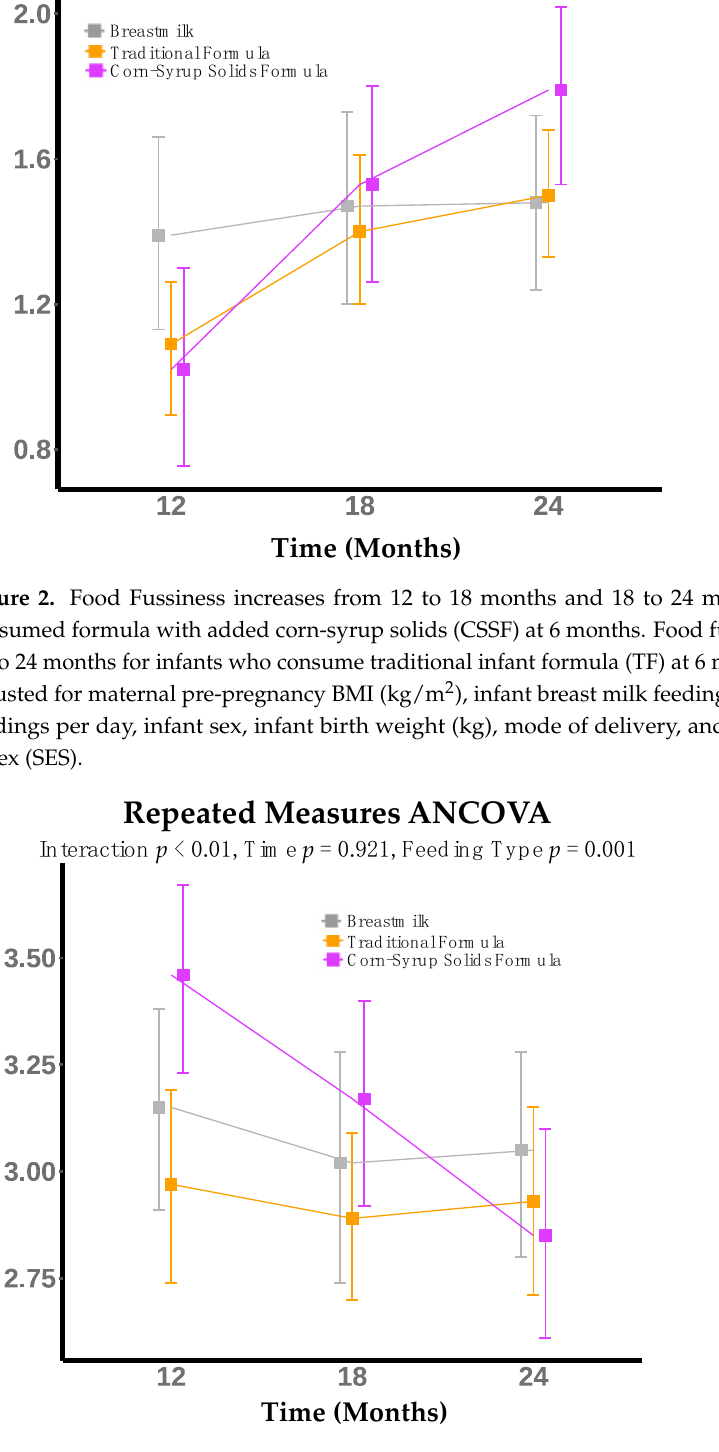
Figure 3. Enjoyment of food decreases from 12 to 24 months for infants who consumed formula with added corn-syrup solids (CSSF) at 6 months. Model adjusted for maternal pre-pregnancy BMI (kg/m 2 ), infant breast milk feedings per day and formula feedings per day, infant sex, infant birth weight (kg), mode of delivery, and socioeconomic status index (SES).